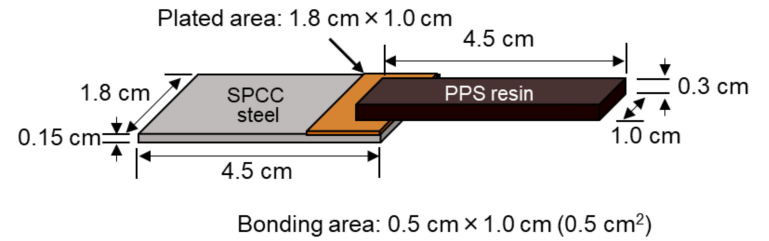
Figure 1. Dimensions of bonded